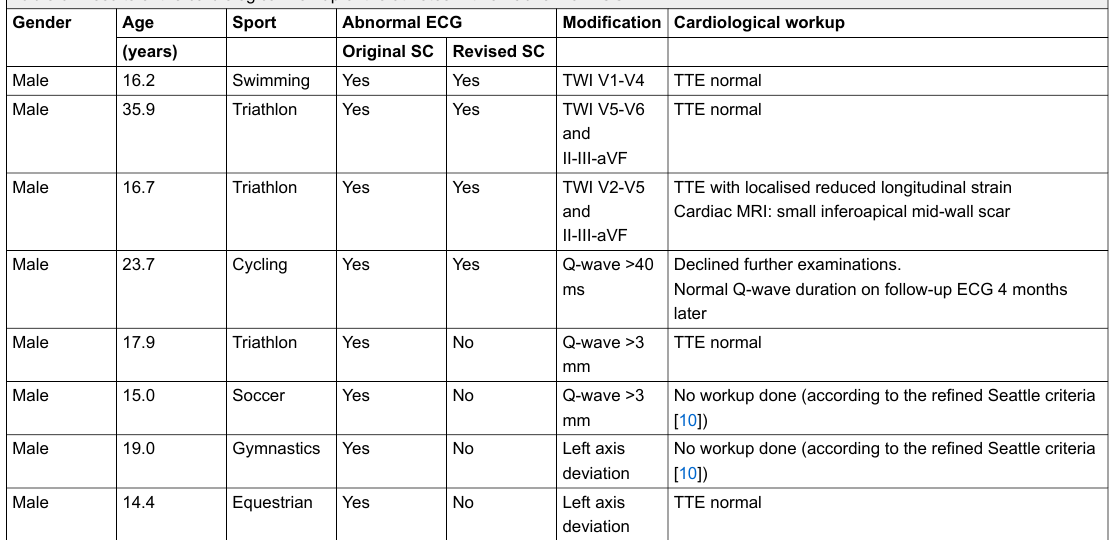
Table 3: Results of the cardiological workup of the athletes with an abnormal